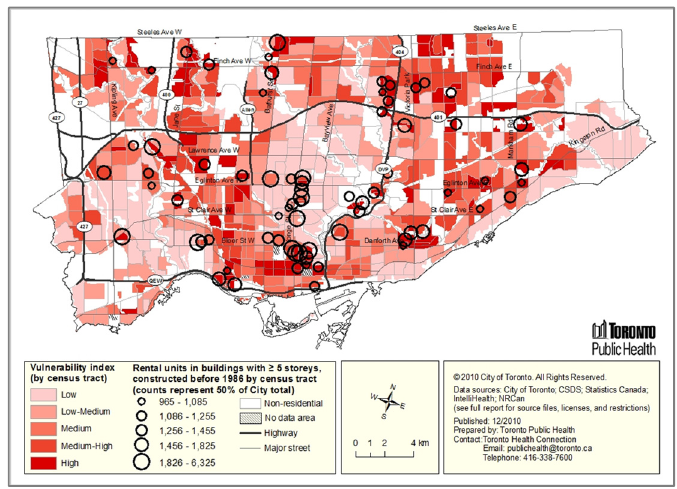
Figure 11. Map of the City of Toronto showing areas of heat vulnerability, in addition to older multi-storey buildings with no air conditioning. (Source: Toronto Public Health, 2010).